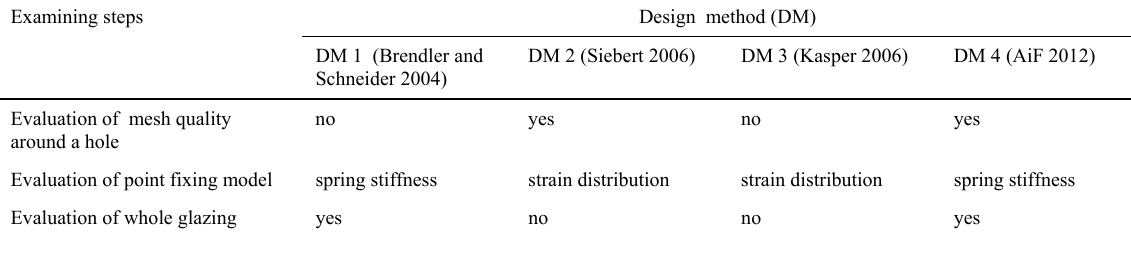
Table 1: Overview of the detailed methods (incl. examining